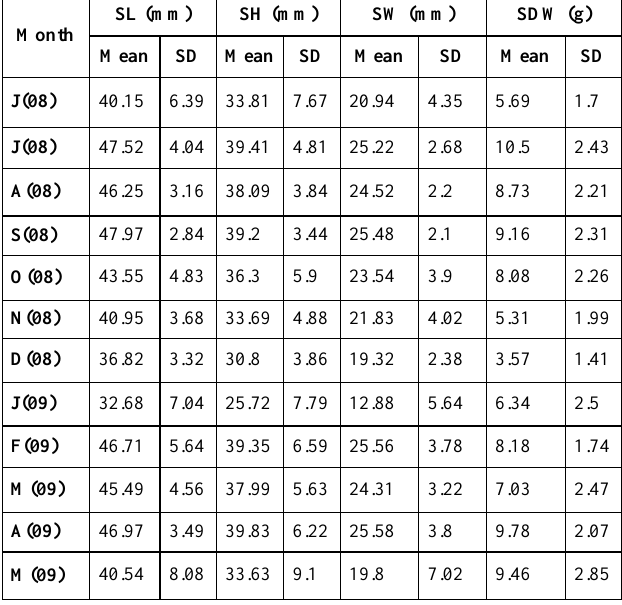
Table1: Biometric measurements of Mactra stultorum during one